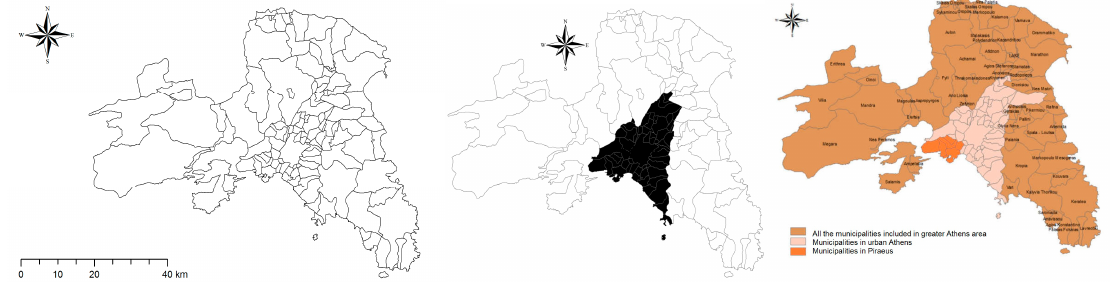
Figure 1. A map illustrating the geography of the study area: municipal boundaries of the study area ( left ); municipalities classified as urban (black) and rural ( center ); and geographic divisions ( right ).